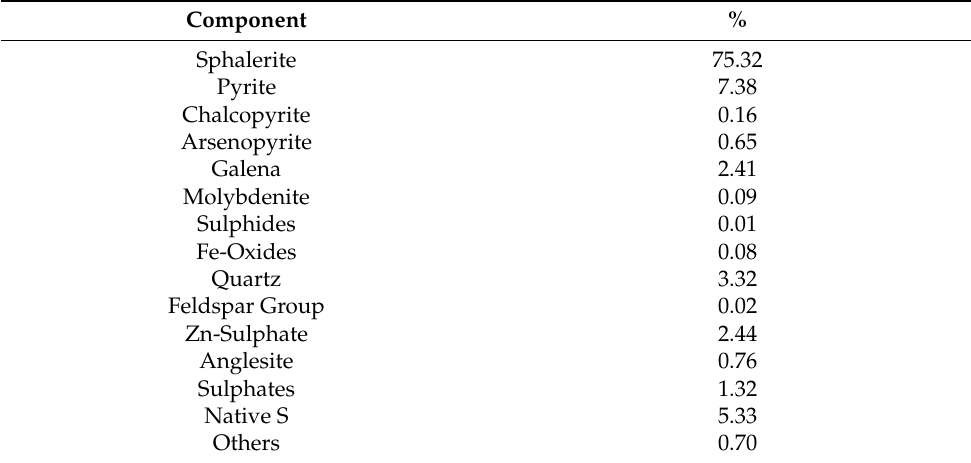
Table 2. Mineralogical characterization of zinc concentrate.